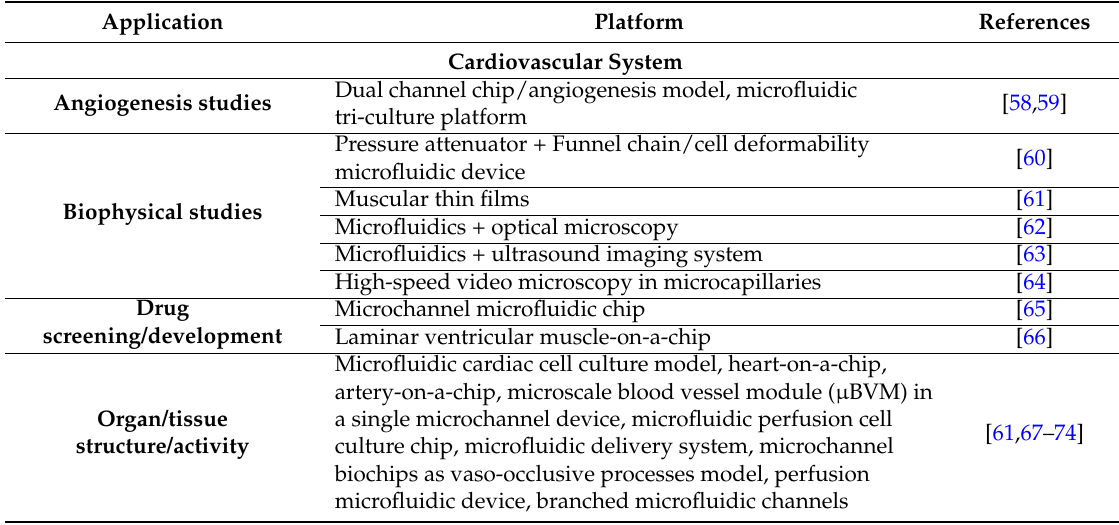
Table 1. Recent applications of